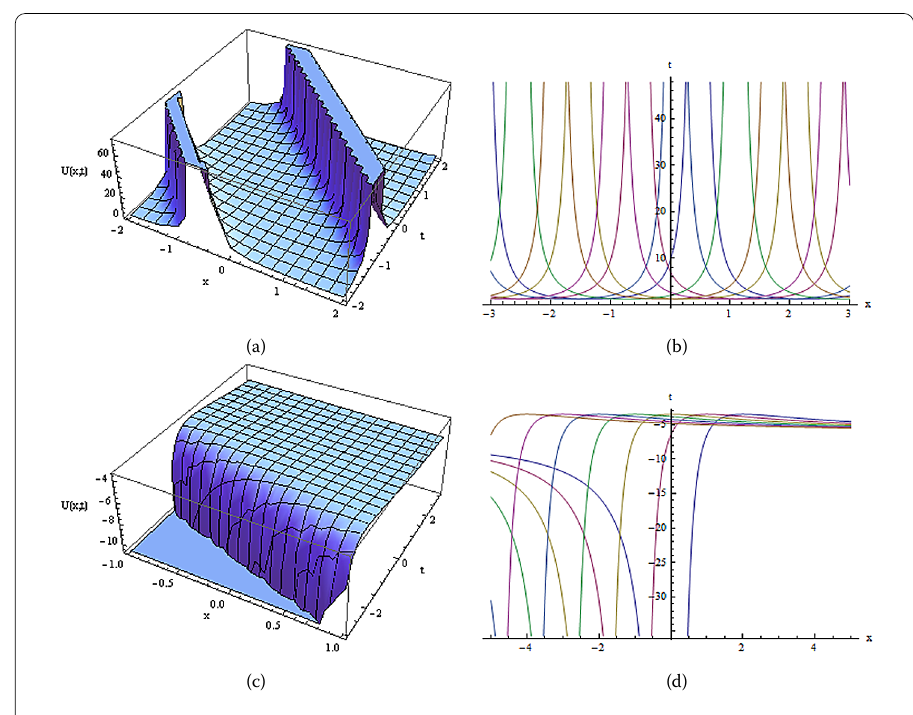
Figure 3 The 3D surfaces of Eq. (18) for the solution (25) at ( a ) and for solution (26) at ( b ) by assigning different values to the parameters